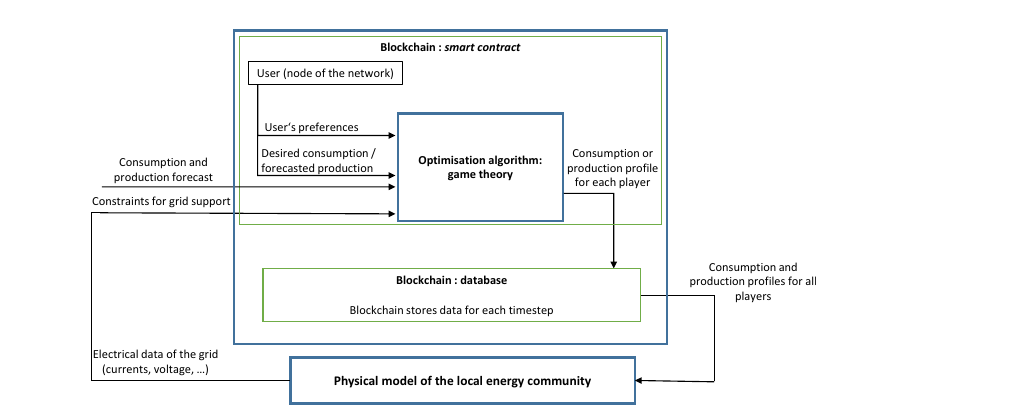
Figure 5. Overview of the overall optimisation process